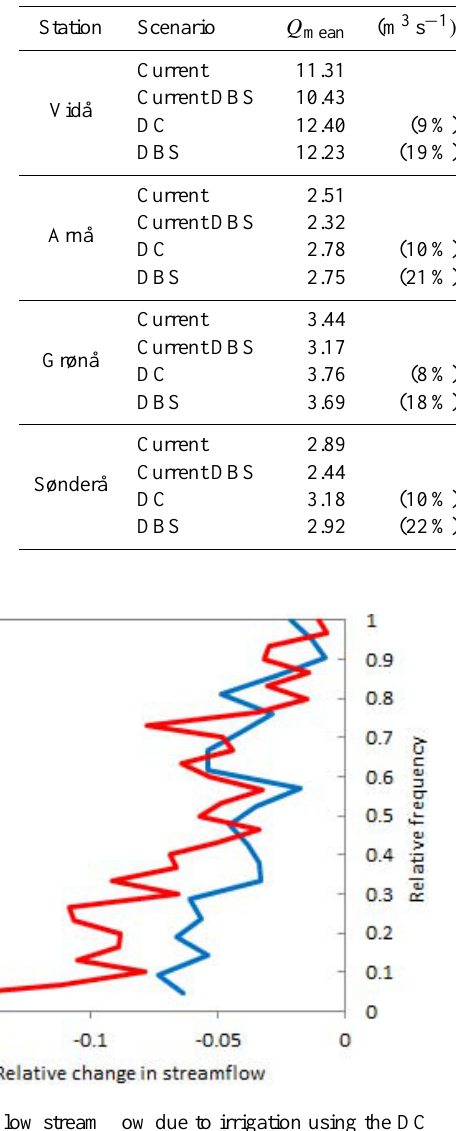
Table 7. Mean flow, median minimum flow and 5-percentile flow for the current climate and future climate according to the DC and DBS